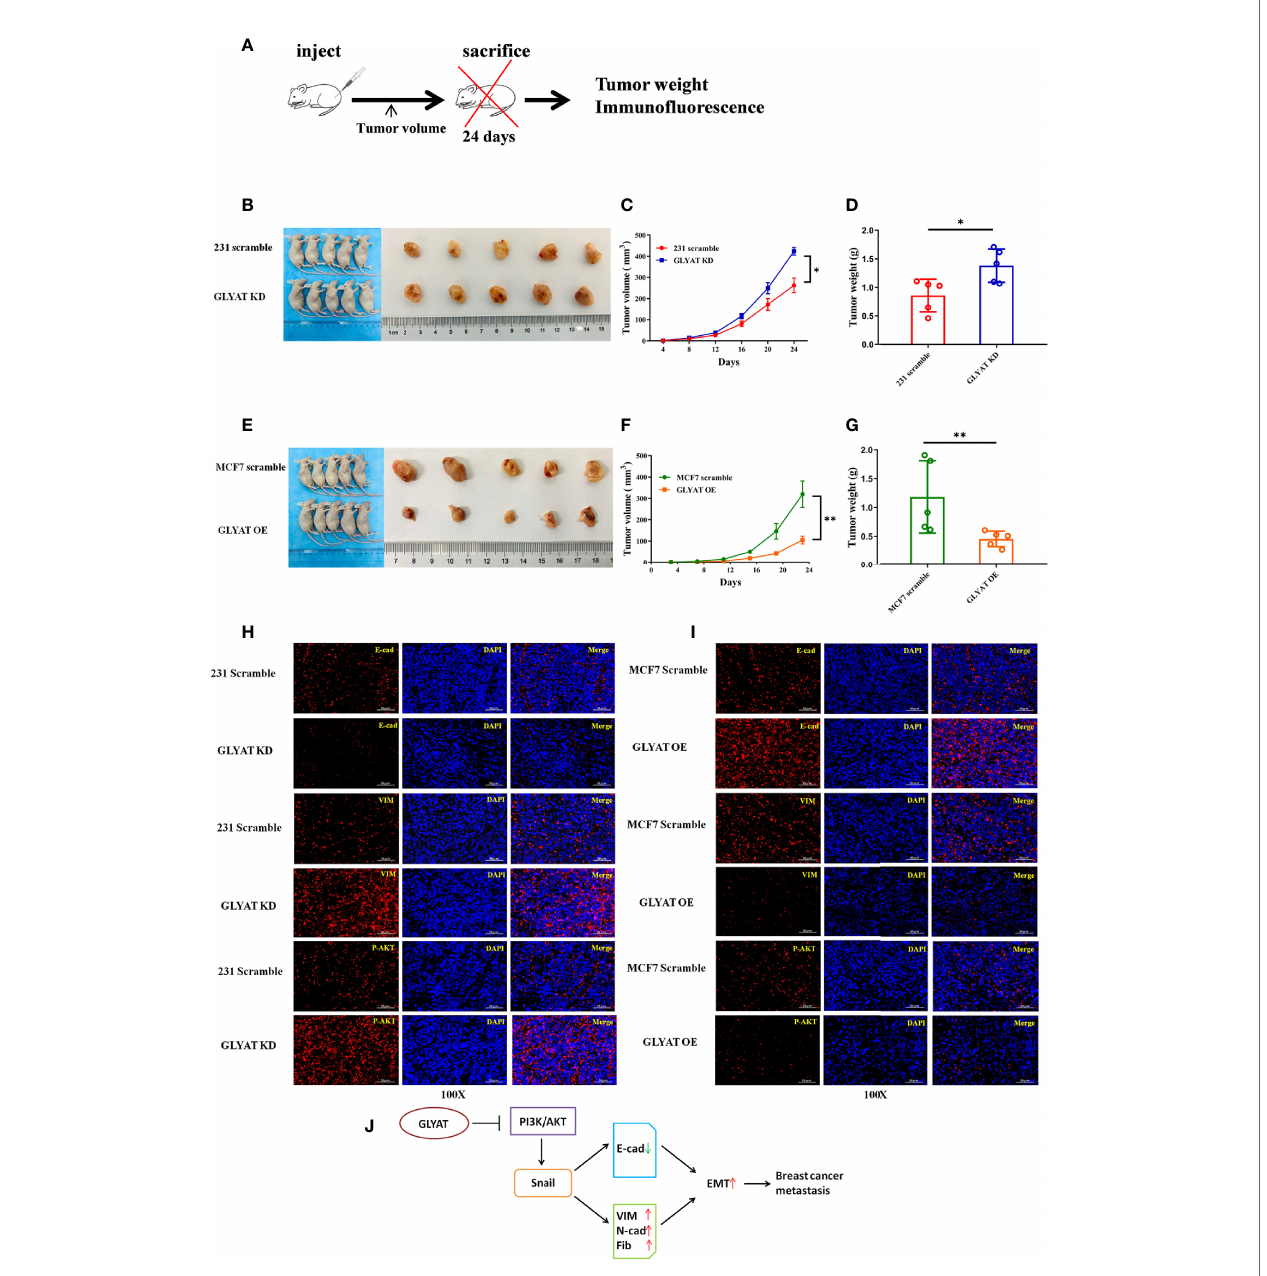
FIGURE 5 | GLYAT suppresses breast cancer proliferation, metastasis, and EMT in vivo . (A) Schematic diagram of the metastasis model in mice. (B – D) The mice injected with stable GLYAT KD MDA-MB-231 cells had markedly bigger and heavier tumors. (E – G) The mice injected with stable GLYAT OE MCF-7 cells had markedly smaller and lighter tumors. (H) The immuno fl uorescence assay of serial sections of mouse tumor tissues revealed that GLYAT KD MDA-MB-231 cells signi fi cantly decreased the expression of E-cadherin whereas increased the expression of vimentin and p-AKT. (I) The immuno fl uorescence assay of serial sections of mouse tumor tissues revealed that, in GLYAT OE MCF-7 cells, the expression of E-cadherin was increased whereas vimentin and p-AKT were decreased. (J) The schematic diagram of the role of GLYAT in BC. *p < 0.05, **p < 0.01. Scale bars are 50